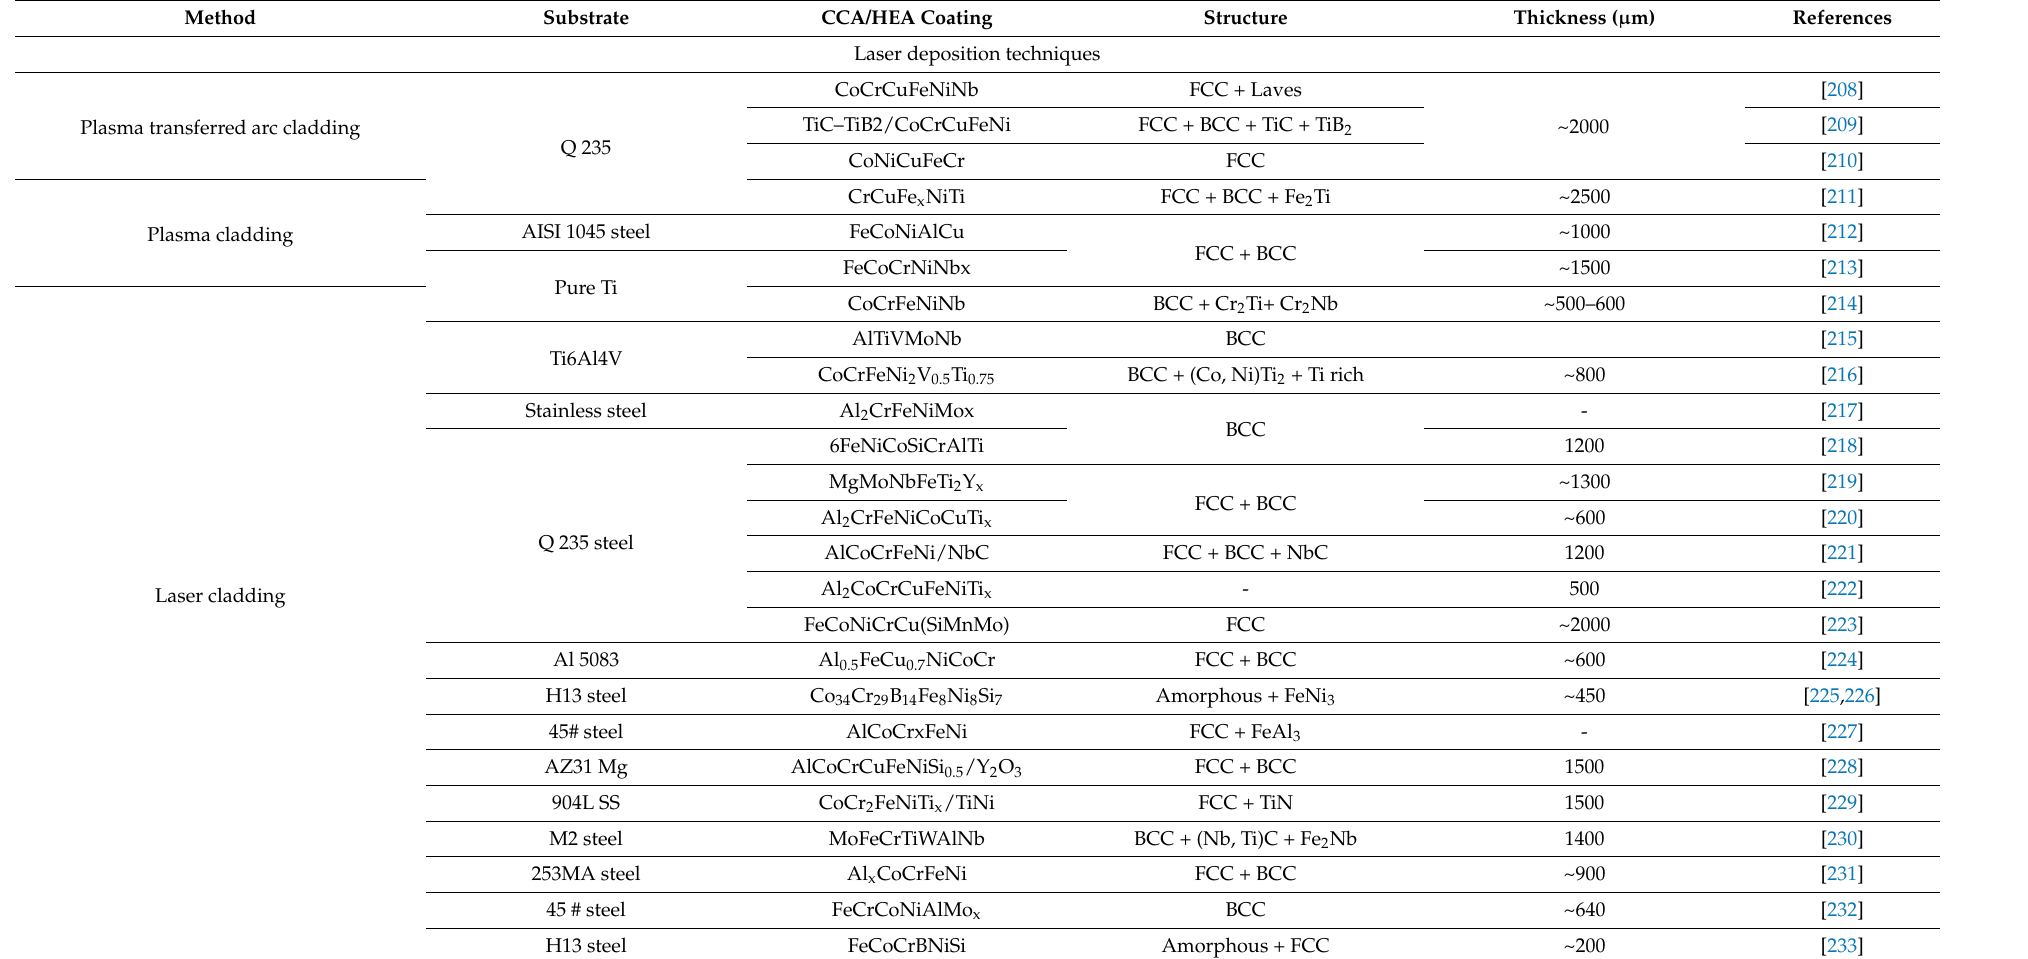
Table 8. Different types of coating systems on different substrates and the resulting crystal structures and